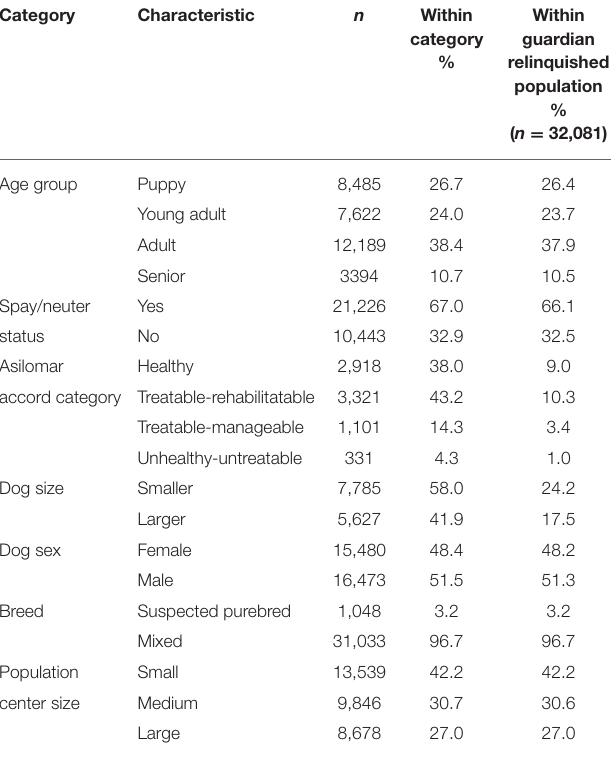
TABLE 1 | Classification of dog characteristics and their percentage within each category and within the total population ( n =